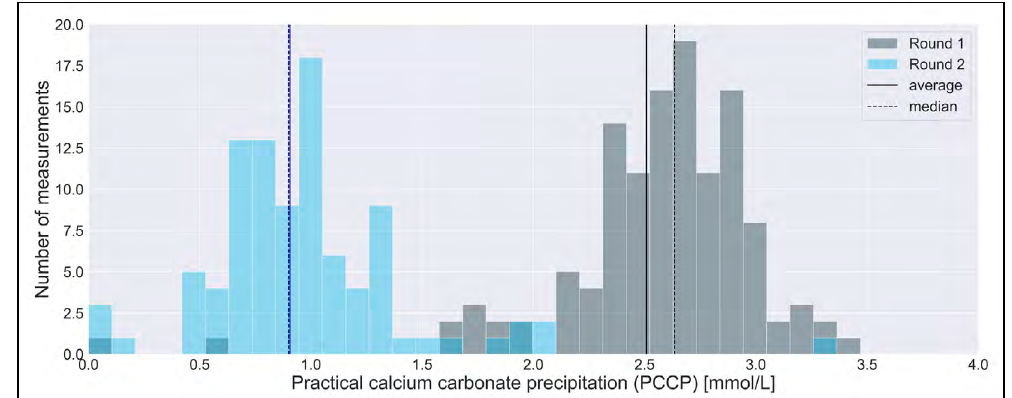
Figure 4 Practical calcium carbonate precipitation (PCCP), derived from hardness measurements.